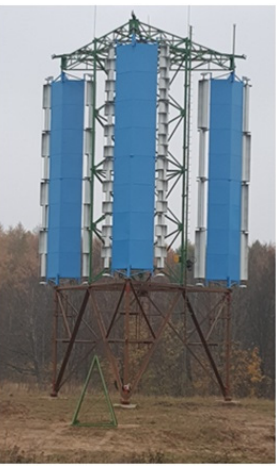
Figure 14. Innovative wind power